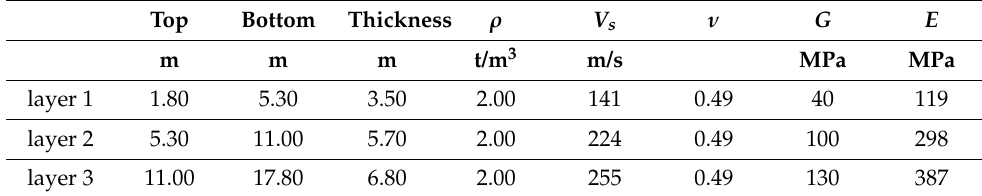
Table 1. Characteristics set for the three homogeneous soil layers used in the model.